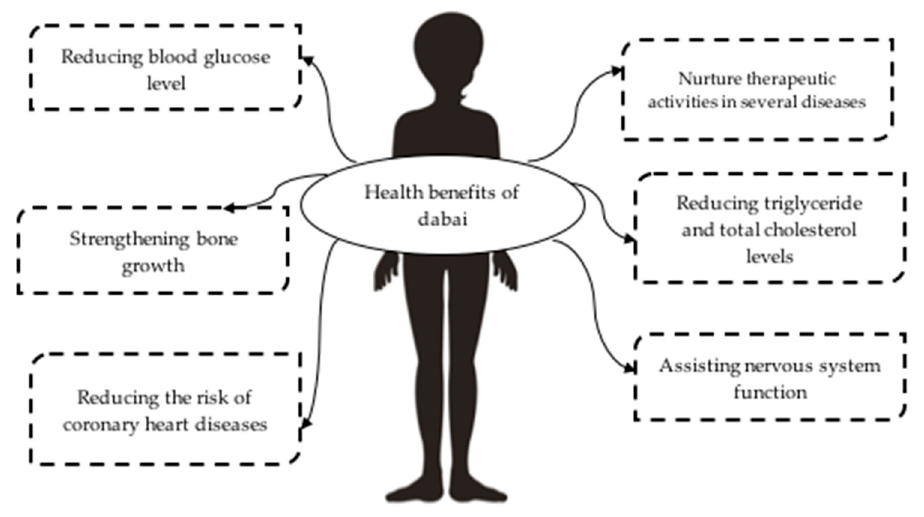
Figure 3. Potential health benefits of